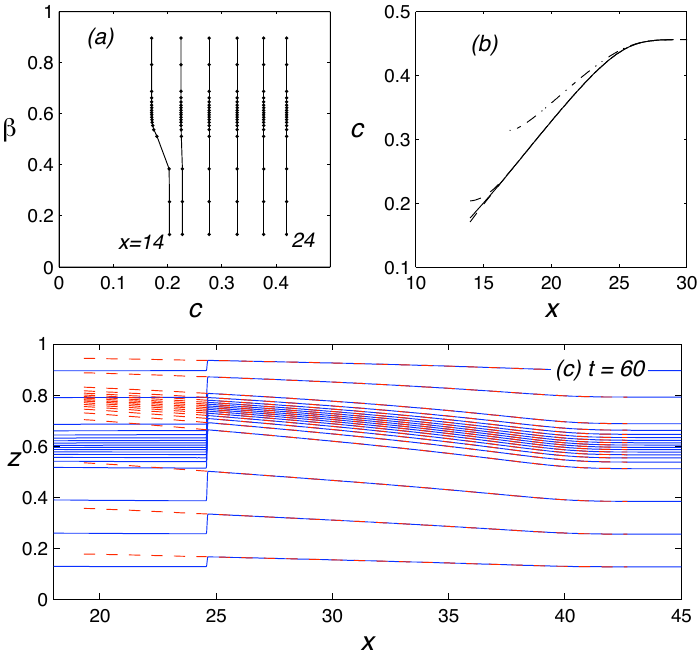
Fig. 7. (a) Speed c of interfacial points as a function of β at x = 14, 16, 20, 22, and 24 computed from the numerical solution in Fig. 6 at t = 30. (b) Interfacial speed c as a function of x in the rarefaction region of the numerical solution at t = 30. The solid line shows the average and the dashed lines the maximum and minimum in β . The dash-dot line shows c(x) predicted from the weakly non-linear model Eq. (15) and the initial condition. (c) Close-up of the interface positions from the numerical solution in Fig. 6 at t = 60 (blue solid lines) and the prediction from assuming simple wave behavior from (30) with c(ξ) from (b) (red dashed